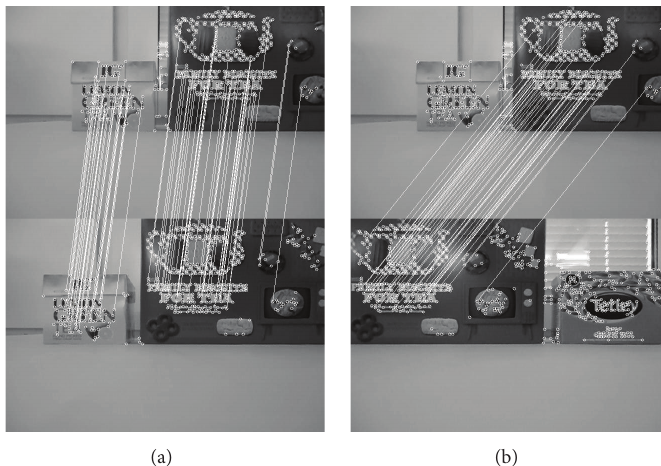
Figure 7: Initial video frame is matched with subsequent frames of the video using FAB descriptor to show matching under scale differences. Results are shown for frame #1 matched with frame #150 (a) and frame #205 (b).